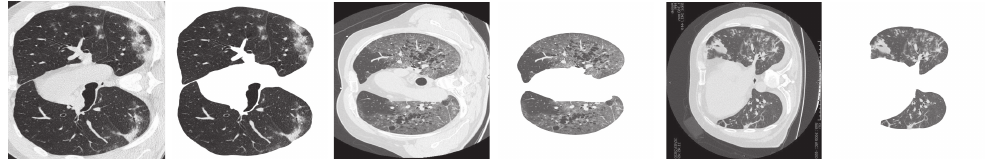
Figure 8. Outcomes of extraction lung region